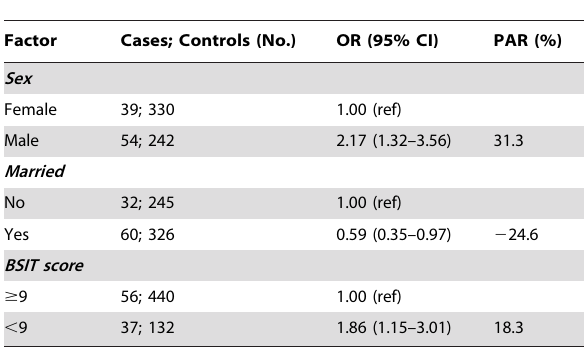
Table 4. PARs for incident MCI or dementia a